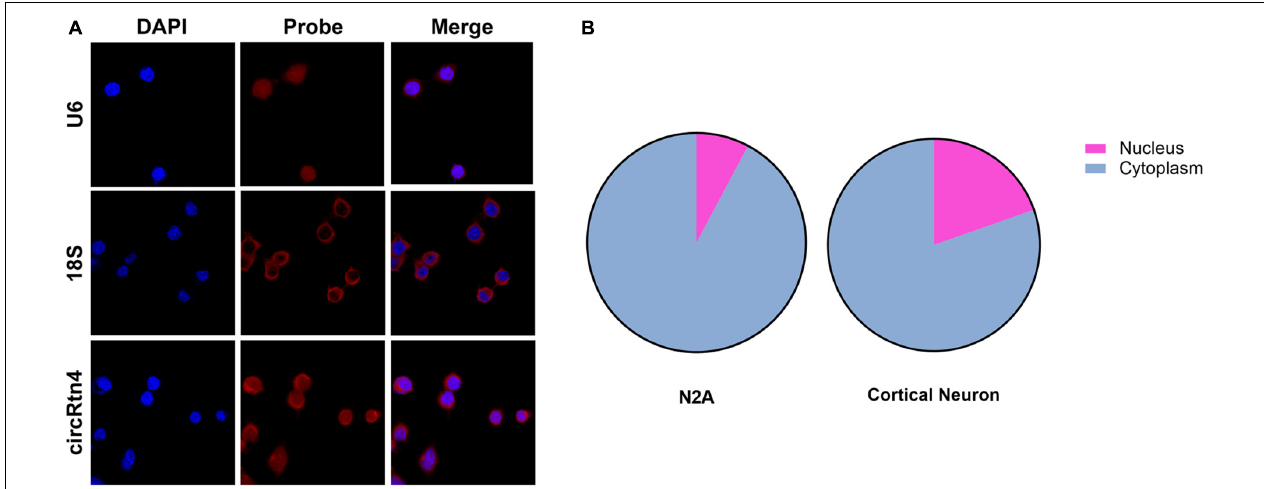
FIGURE 4 | The localization of circRtn4 in N2a cells. (A) RNA FISH showed the localization of circRtn4 in N2a cells. (B) After nuclear and cytoplasmic isolation in N2a cells and primary cortical neurons, the expression levels of circRtn4 were examined by qRT-PCR.